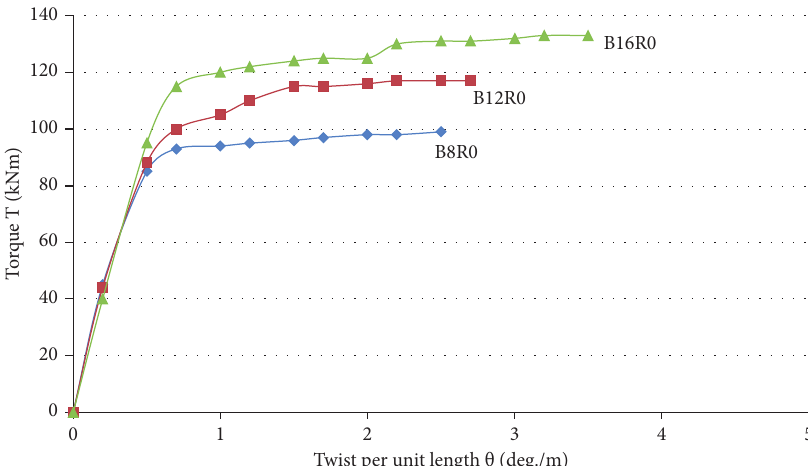
Figure 8: Experimental torque-twist response for beams with normal aggregate.